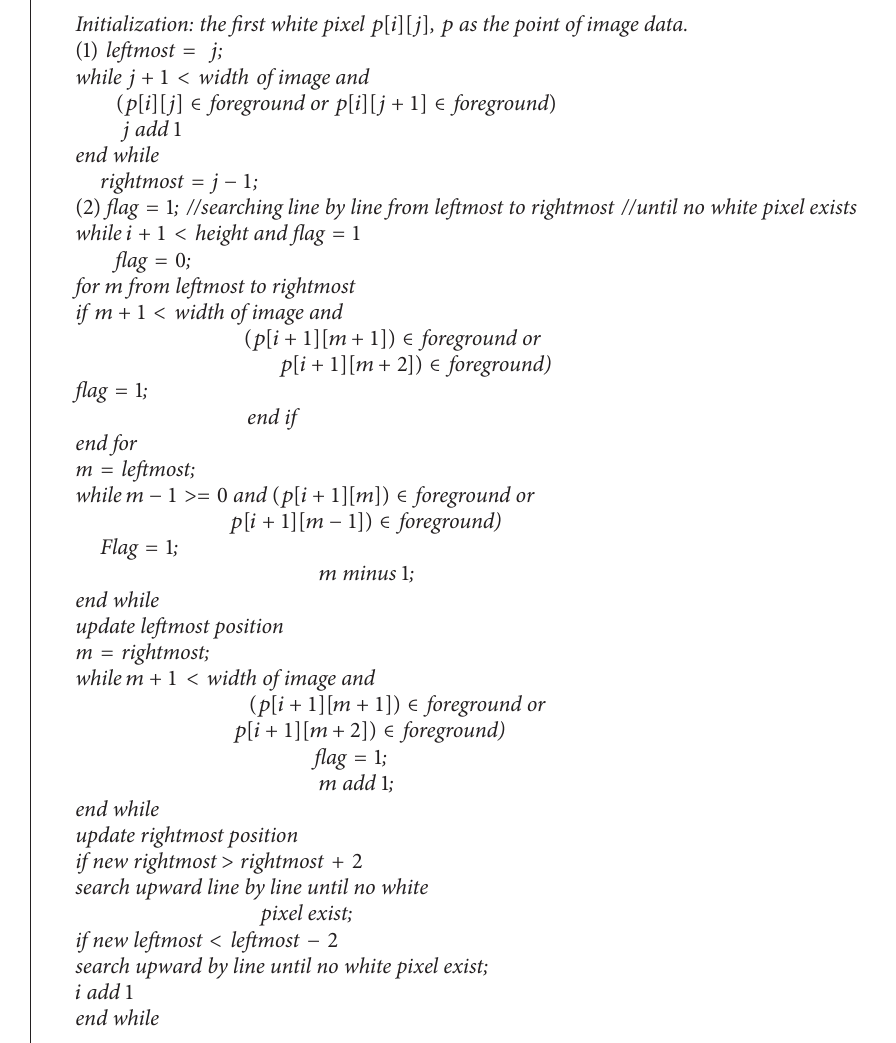
Algorithm 1: Pseudocode for sole blob